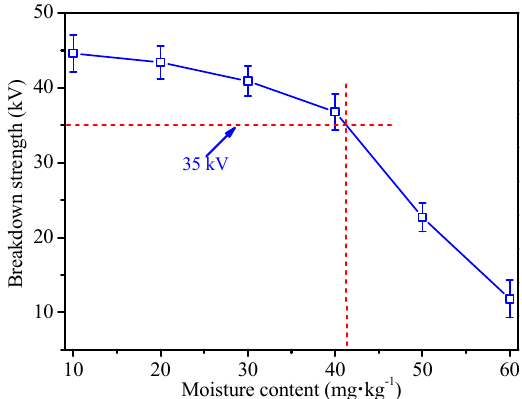
Figure 3. Relationship between the breakdown strength and moisture content of mineral insulating oil.